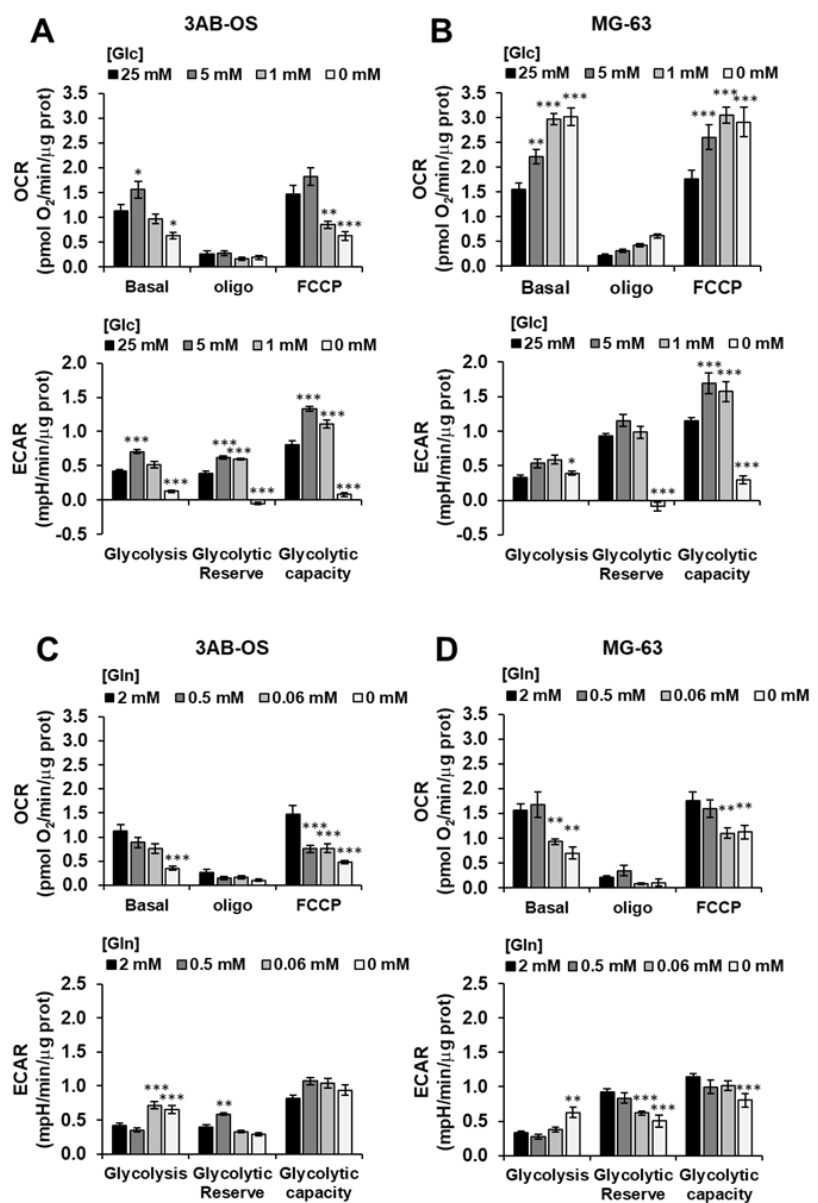
Figure 4. Effects of nutrient availability on the metabolic fluxes of osteosarcoma cell proliferation. 3AB-OS ( A , C ) and MG-63 ( B , D ) were incubated 48 h with the indicated different concentrations of glucose (Glc) or glutamine (Gln) and OCR and ECAR measured by Seahorse as in Figure 1A,B. Bars indicate mean ± SEM of 3 biological replicates each carried out in triplicate. Statistical significances are referred to control; * p < 0.05, ** p < 0.005, *** p < 0.001. Abbreviations: OCR , oxygen consumption rate; ECAR , extracellular acidification